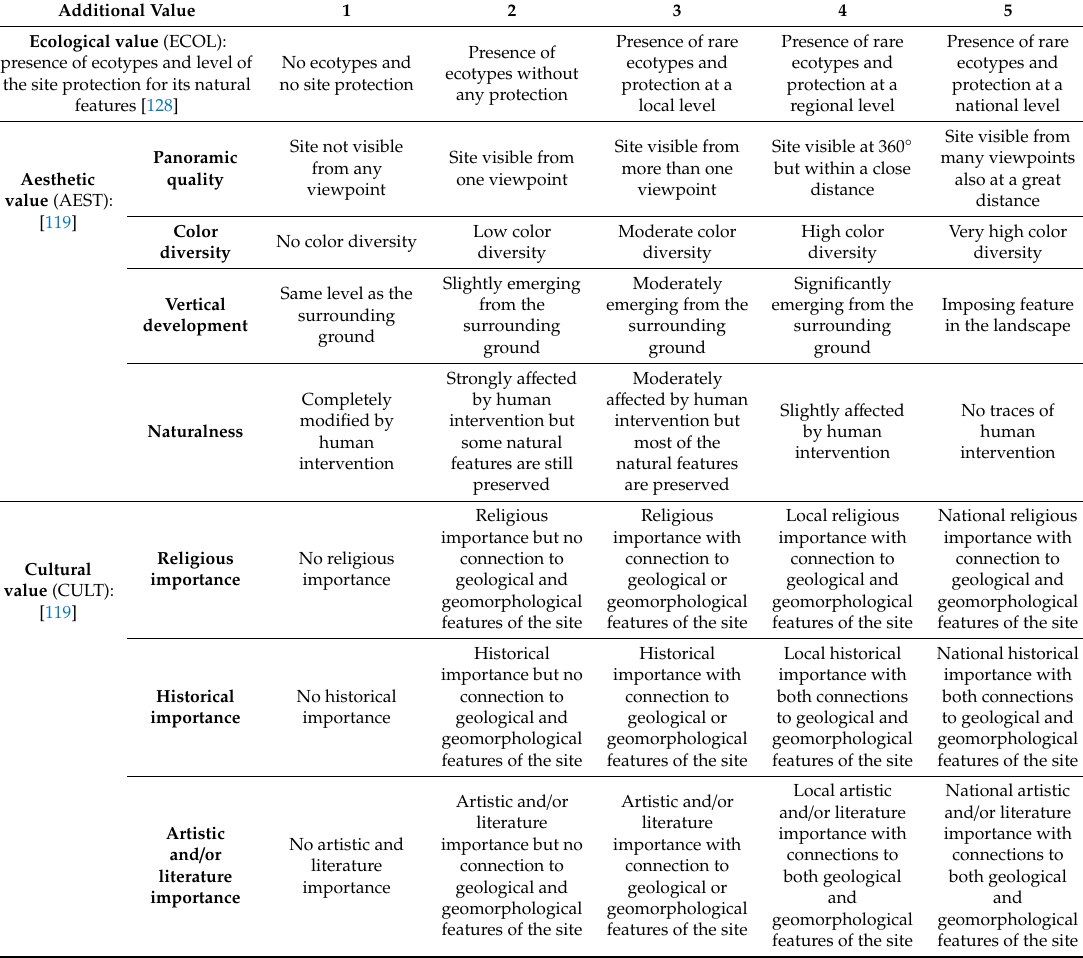
Table 4. Sub-criteria used for the numerical assessment of geosite additional